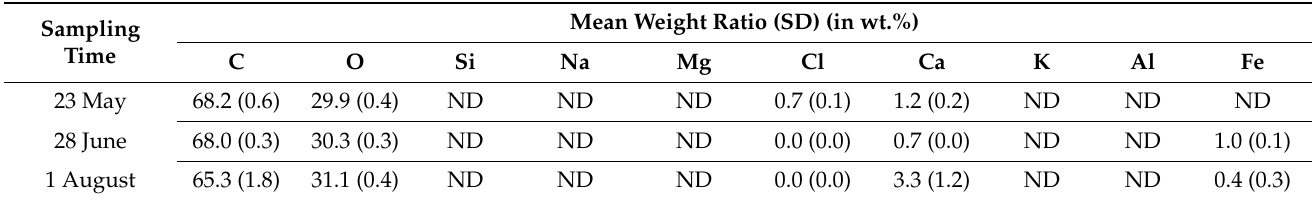
Table 8. Element analysis of the supply air, using SEM-EDS.